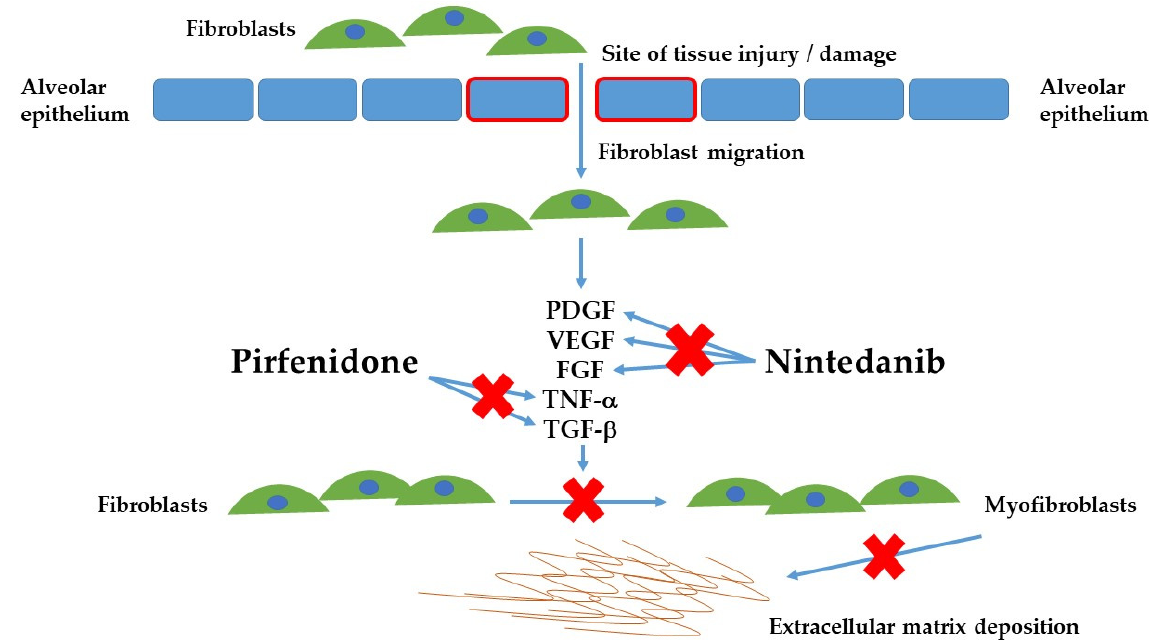
Figure 2. Pathophysiology of PF-ILD and the major mechanisms by which pirfenidone and nintedanib modulate steps in the cycle of lung fibrosis. Adapted from Spagnolo et al. [26]. PDGF: Platelet-derived growth factor; VEGF: Vascular endothelial growth factor; FGF: Fibroblast growth factor; TNF- α Tumor necrosis factor alpha; TGF- β : Transforming growth factor beta.